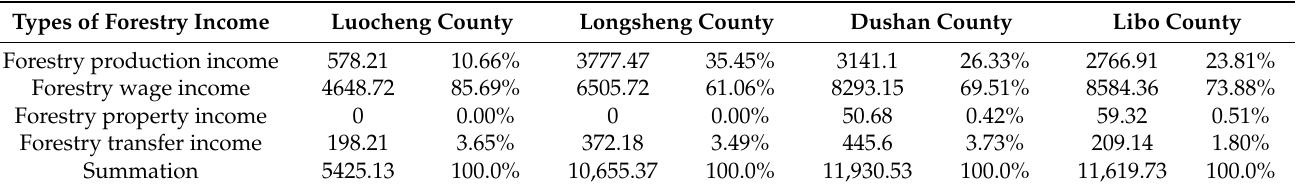
Table 7. Mean and proportion of all types of forestry income for rural households in each county.